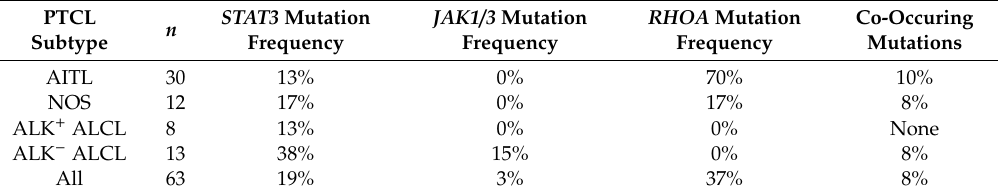
Table 1. STAT3, JAK1/3, and RHOA mutation frequencies in PTCLs.